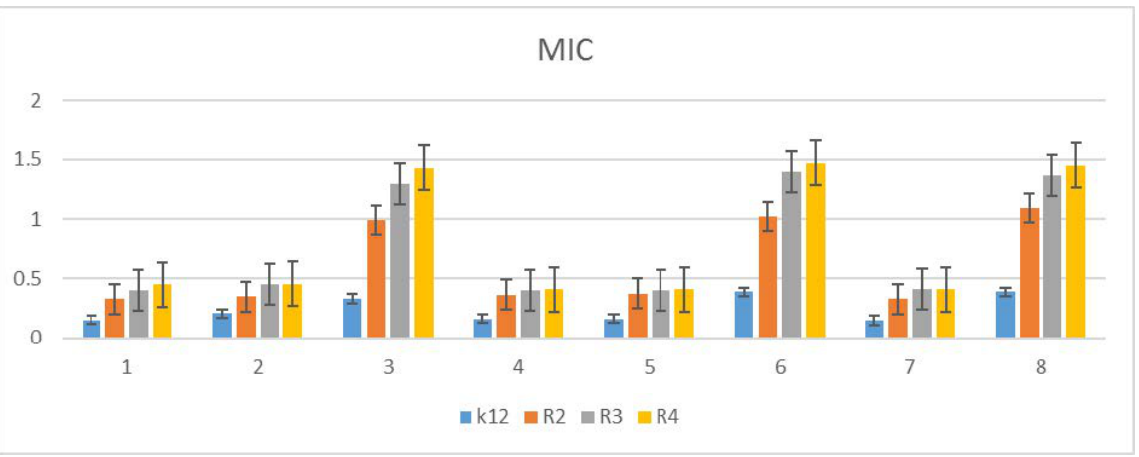
Figure 3. Minimum inhibitory concentration (MIC) of the phosphonate derivatives in model bacterial strains. The x -axis features compounds 1 – 8 used sequentially. The y -axis shows the MIC value in µg/mL. Investigated strains of E. coli K12 as control (blue), R2 strains (orange), R3 strain (grey), and R4 strain (yellow). The order in which the compounds were applied to the plate are shown in Supplementary Materials Figure S22.